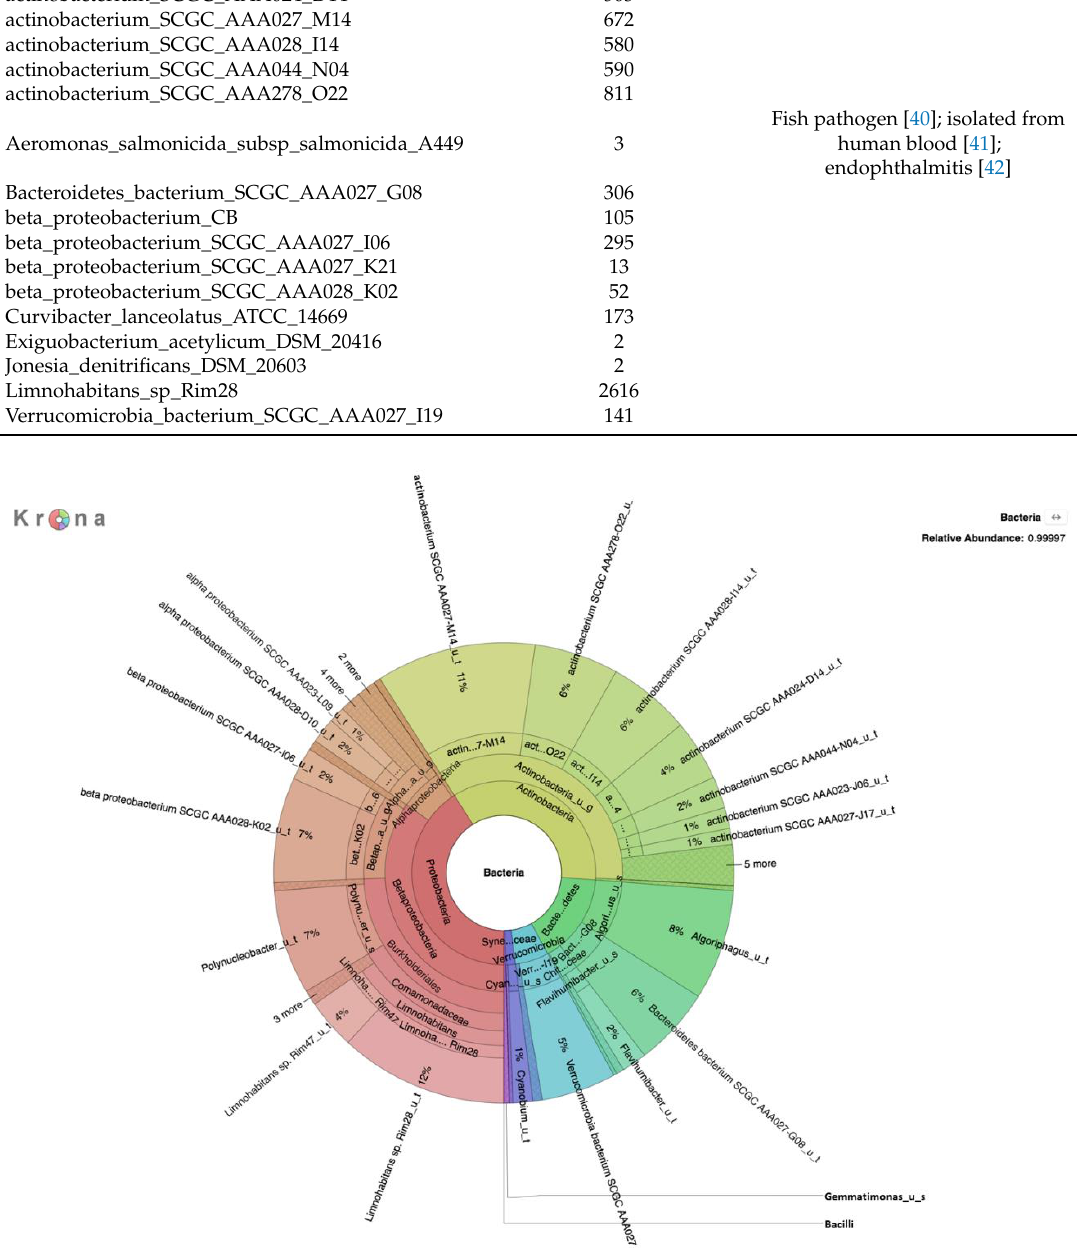
Figure 1. Krona plot of bacteria identified in the Little Bighorn River metagenome (DNA prepared without selection).